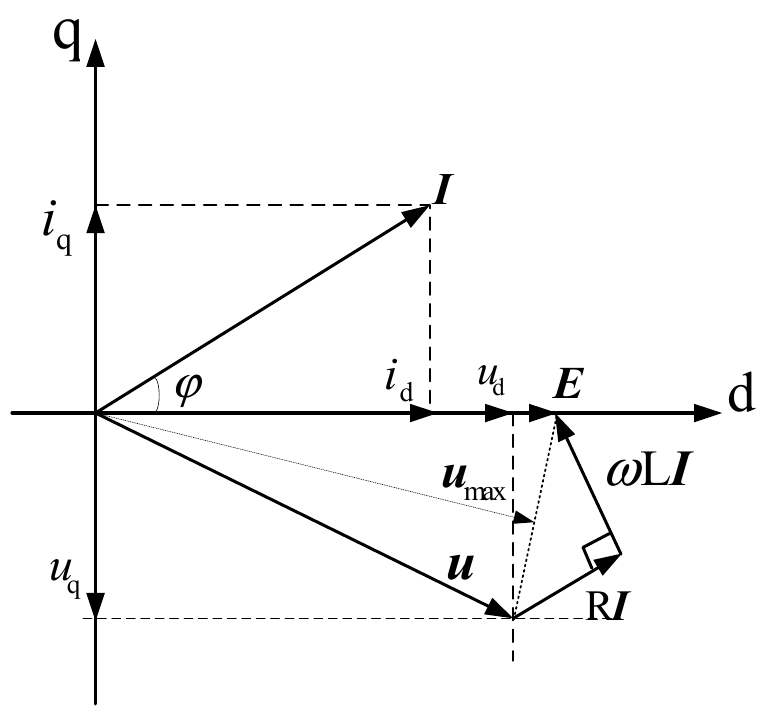
Figure 3. Steady-state voltage space vector diagram of grid-side inverter.